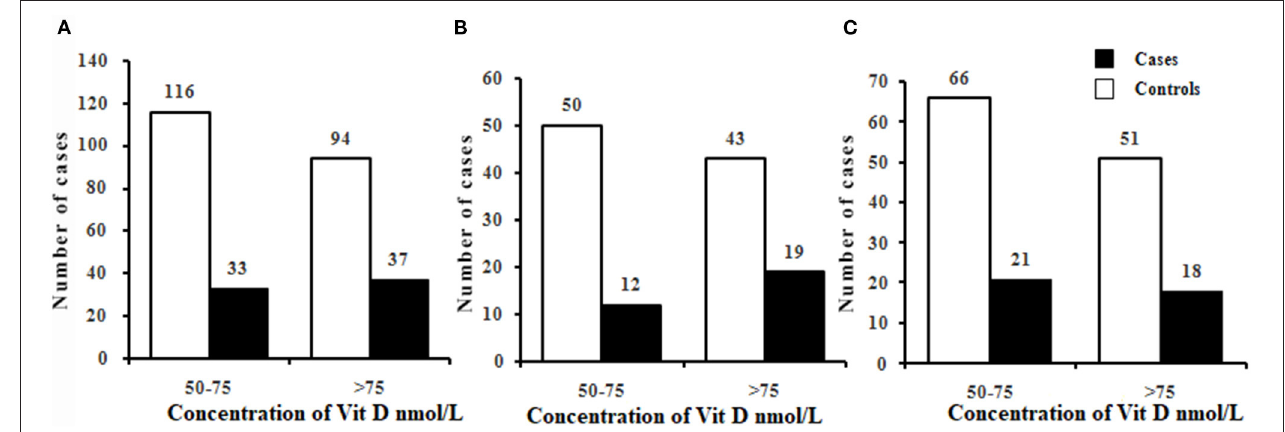
FIGURE 1 | Prevalence of vitamin D insufficiency in cases and controls in the total (A) , male (B) , and female (C) . Chi-square tests were used to compare the differences in the prevalence of vitamin D insufficiency between cases and controls. There were no significant differences in the prevalence of vitamin D insufficiency between cases and controls in the total, male, and female (all P > 0.05). Vitamin D groups: vitamin D insufficiency (50–75nmol/L); vitamin D sufficiency ( > 75nmol/L).